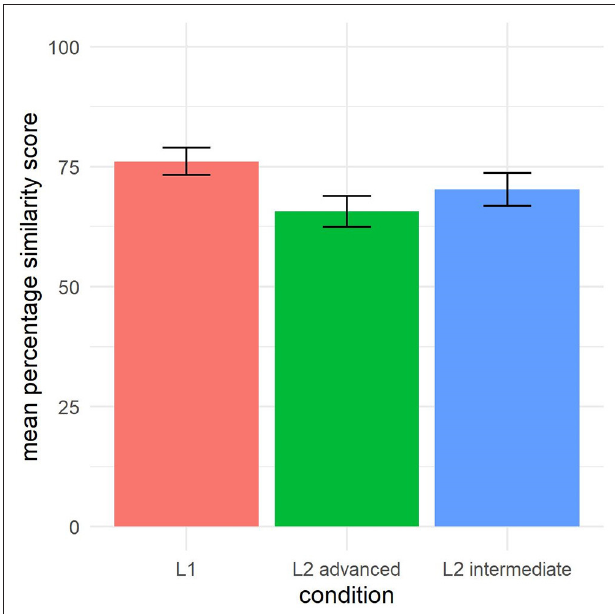
FIGURE 1 | Recall as mediated by condition (error bars: standard error).